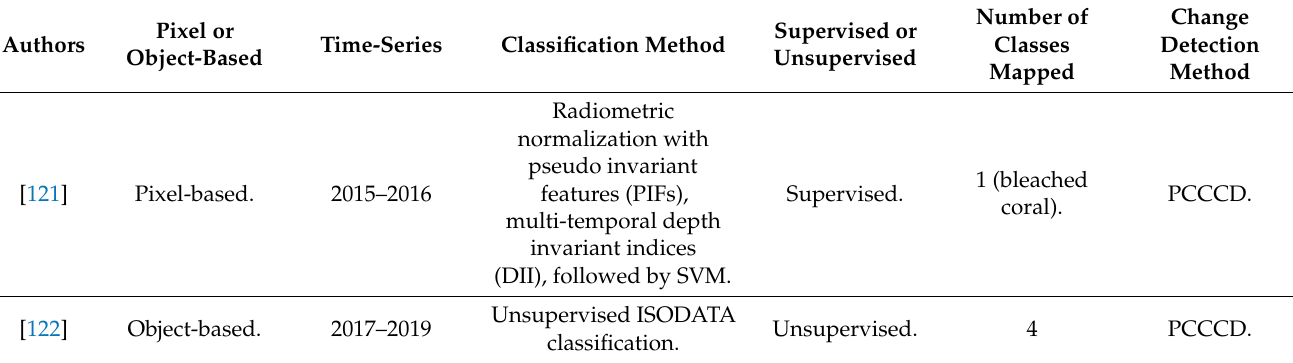
Table 3. Coral reef benthic change detection publications